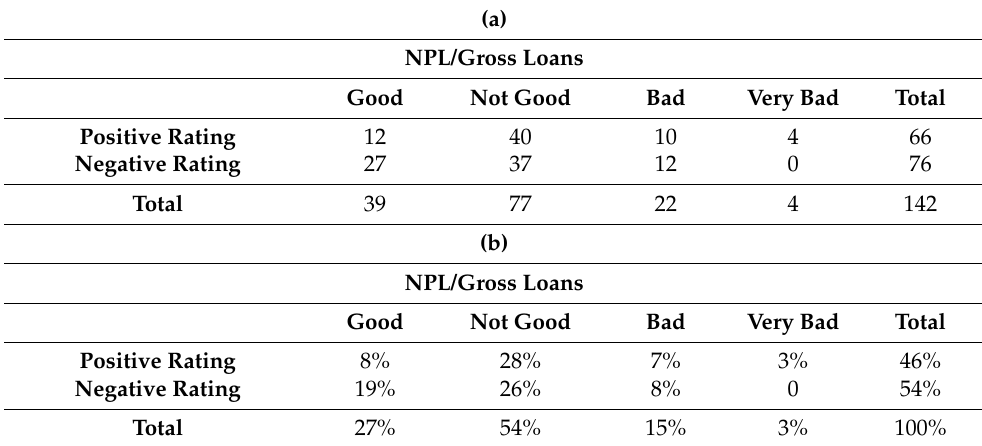
Table 4. Clustering banks according to BTIR and NPLs based on gross loans evidence (own computa- tion): ( a ) results of the clustering in terms of absolute values, and ( b ) results of the clustering in terms of percentages composing the sample.